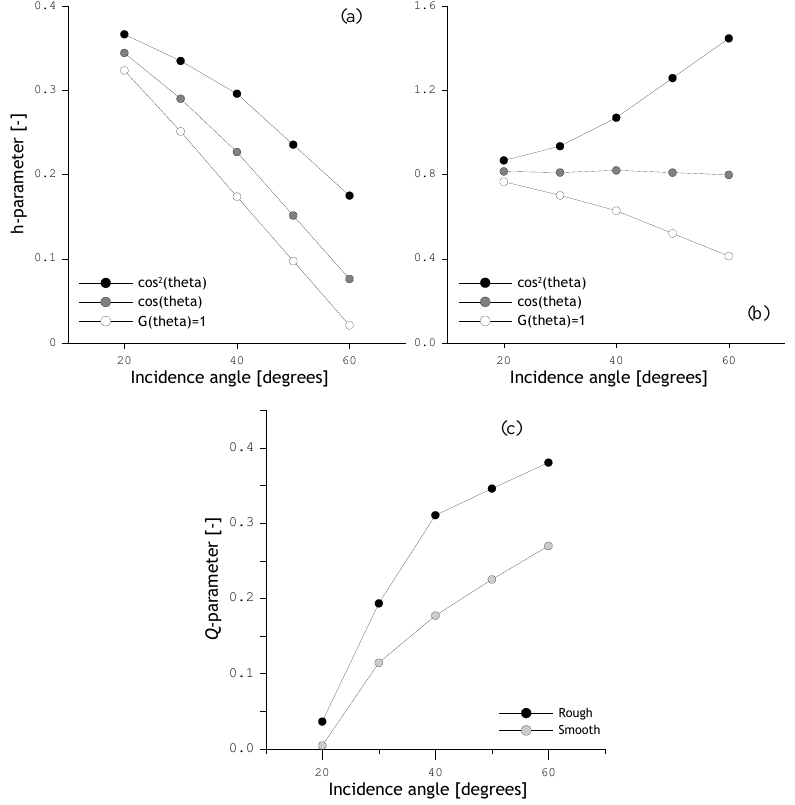
Figure 7. h -parameter as a function of incidence angle calculated from dual-polarized L-band T ‘s measured over (a) smooth bare soil surface and (b) rough bare soil surface. B (c) Q -parameters as a function of the incidence angle for same smooth and rough